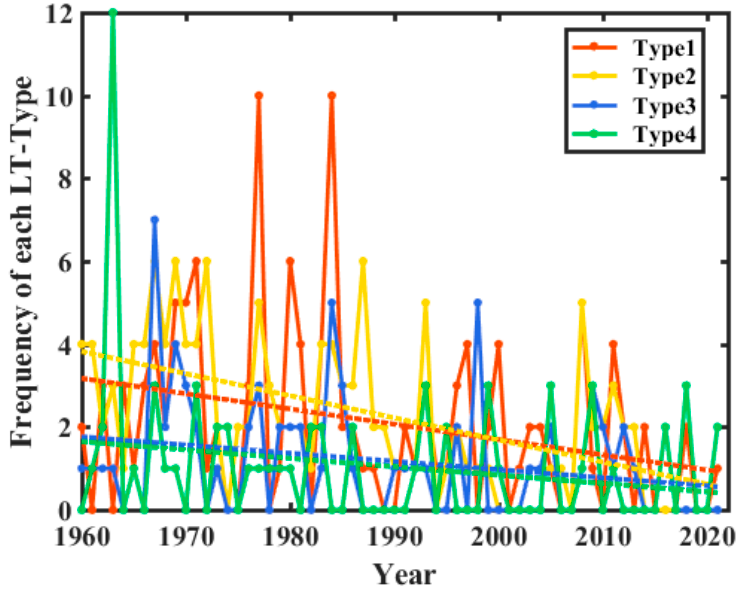
Figure 8. Changes in the frequency of low temperature (LT) days corresponding to each of the four synoptic weather types.